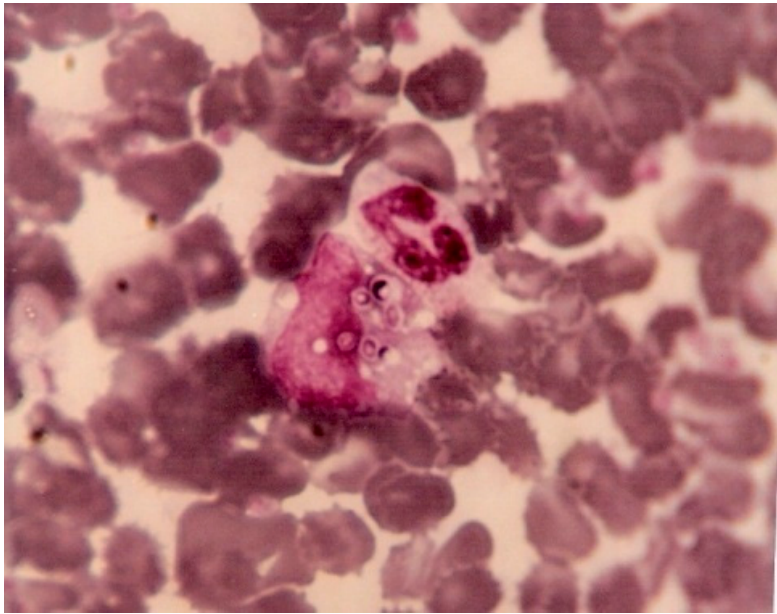
Figure 2. Histoplasma capsulatum yeasts on a stained buffy coat (Giemsa ×100), Ceara, Brazil.